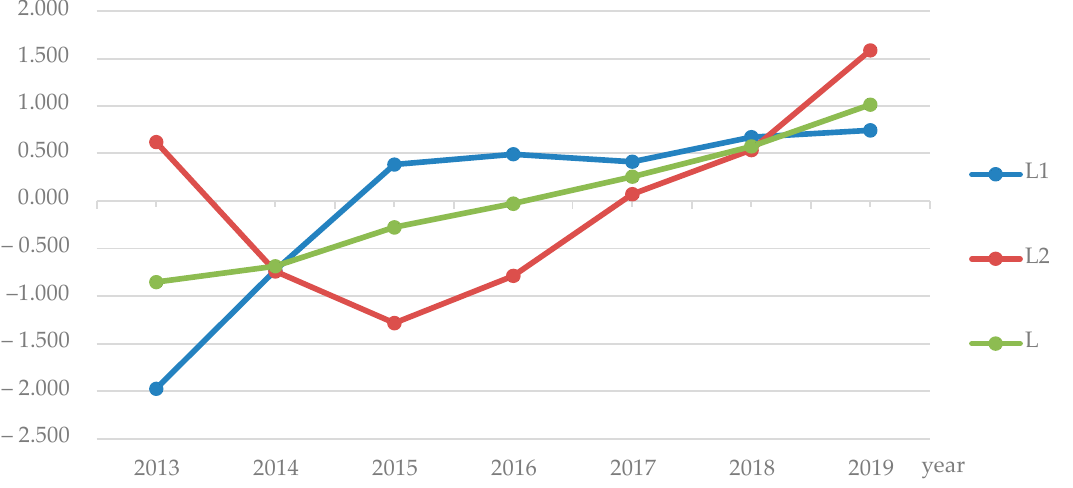
Figure 2. Trend of the main component scores of Huai’an City from 2013 to 2019.